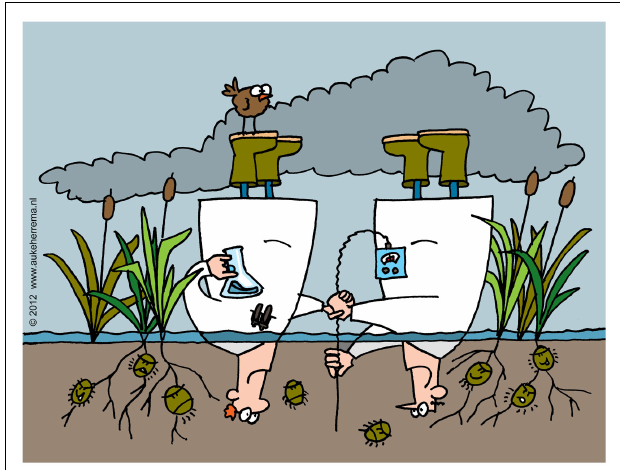
FIGURE 1 | Below-ground scientific collaboration in wetlands: microbiology meets plant ecology. Cartoon by Auke Herrema.